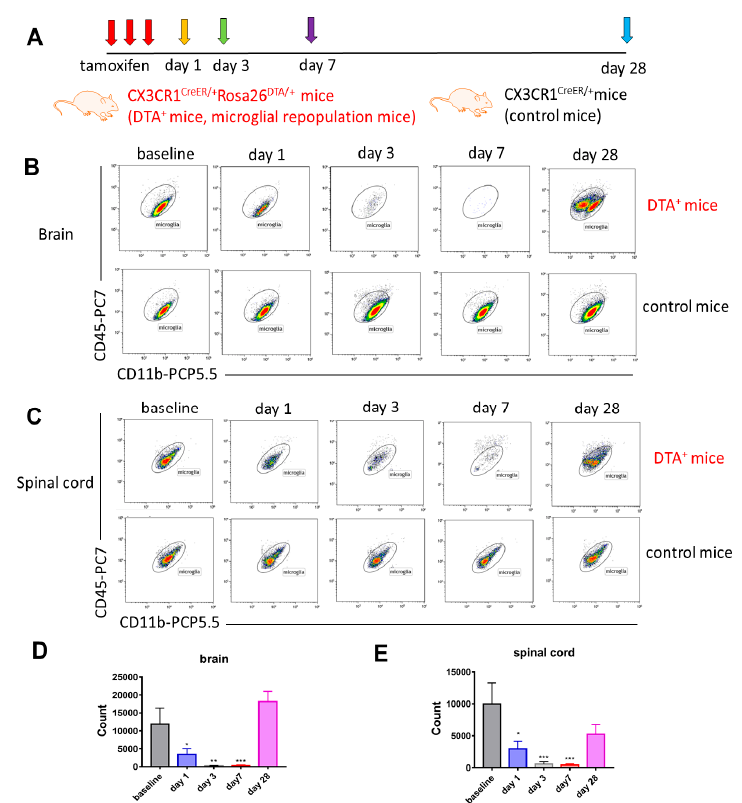
Figure 1. Long-term engraftment of microglia-like cells in Cx3cr1 CreER/+ Rosa26 DTA/+ mice ( A ) Cx3cr1 CreER/+ Rosa26 DTA/+ and Cx3cr1 CreER/+ mice were sacrificed at different time points (day 1, 3, 7 and